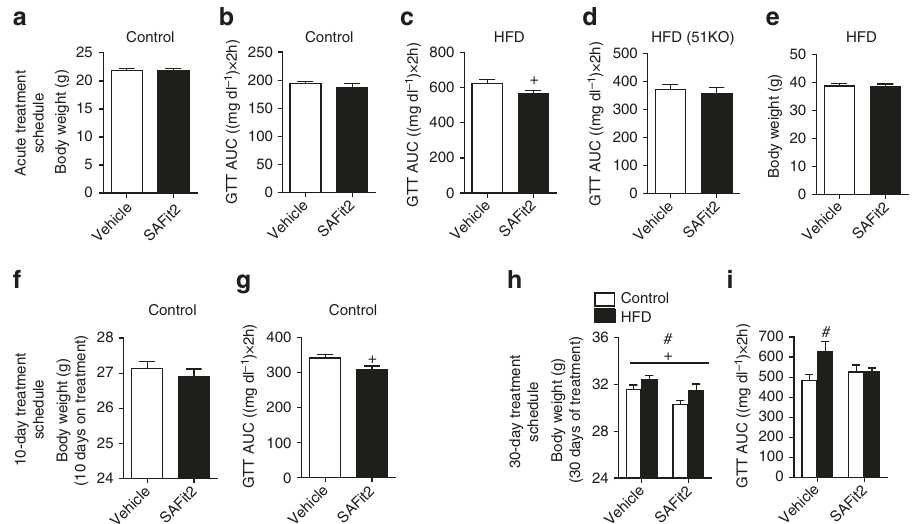
Fig. 3 FKBP51 antagonism parallels the metabolic effects resulting from genetic ablation of FKBP51. a A single application of a slow-release-formulated SAFit2 gel had no effect on glucose tolerance or ( b ) Body weight under control diet conditions. c Under HFD conditions, acute administration of SAFit2 gel signi fi cantly improved glucose tolerance. d The effects of SAFit2 on glucose tolerance under HFD conditions were not present in 51KO. e Despite the effects of acute SAFit2 on glucose tolerance under HFD conditions, there was no effect on body weight ( f ) 10-day SAFit2 treatment had no signi fi cant effect on body weight. g Despite no effect on body weight, SAFit2 treatment signi fi cantly improved glucose tolerance as re fl ected in the glucose area under the curve (AUC) for the GTT measured on treatment day 8. h At the experimental end point (following 30 days of treatment), mice treated with SAFit2 weighed signi fi cantly less than their diet counterparts. Nevertheless, mice fed with the HFD remained signi fi cantly heavier independent of treatment. i The extended SAFit2 treatment schedule furthermore protected against HFD-induced impaired glucose tolerance as re fl ected in the glucose AUC measured on day 25. For acute treatment schedule in C57BL6 n = 12 per treatment group; for acute treatment in 51KO n = 8 per treatment group. For the 10-day treatment schedule, n = 8 per treatment group. For 30-day treatment schedule n = 12 Vehicle-Control, n = 13 SAFit2-Control, n = 12 Vehicle-HFD, n =